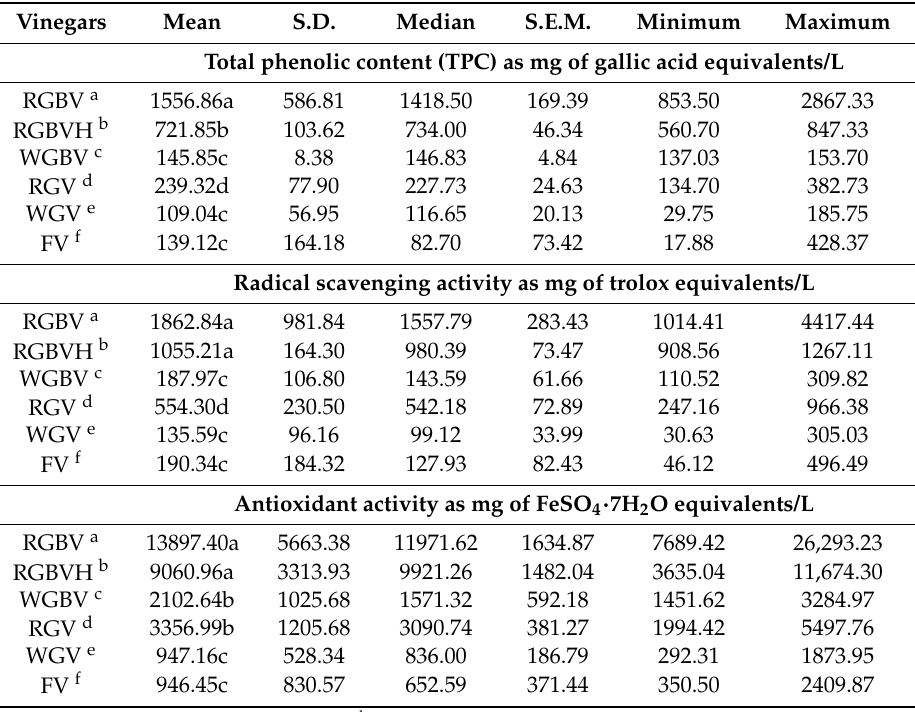
Table 2. Descriptive statistics of total phenolic content (TPC) and radical scavenging -antioxidant activity of